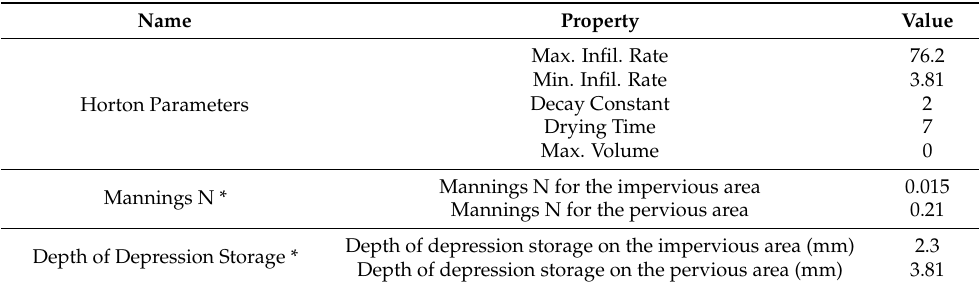
Table 2. The parameters of Horton method, Mannings N and Depth of Depression